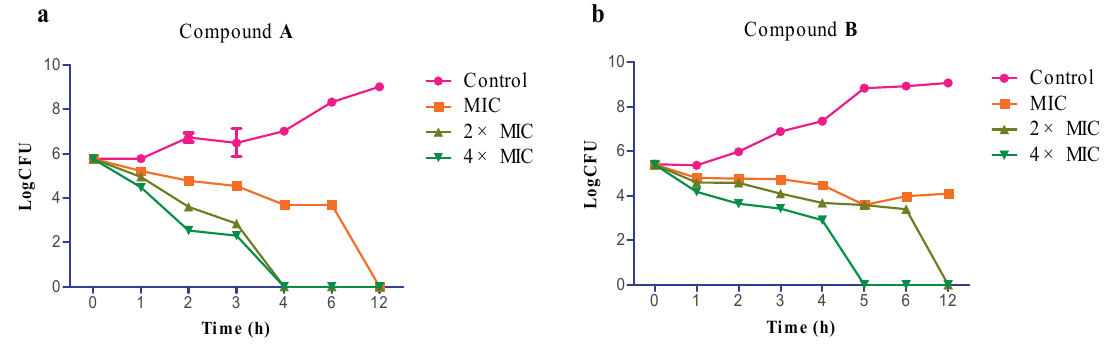
Figure 2. Time-kill assays. Time-kill curves performed in Tryptic Soy Broth (TSB) at 1×, 2×, 4× MIC levels of compound A ( a ), compound B ( b ) against the Staphylococcus aureus. All experiments were performed in triplicate.